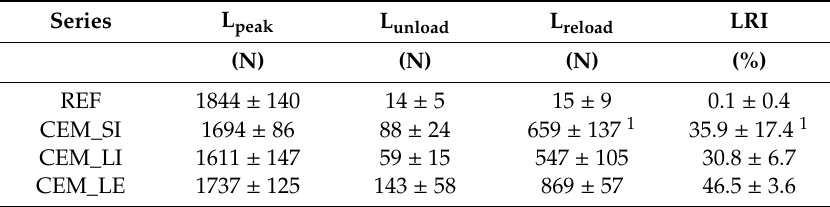
Table 4. Overview of L peak and L unload (average values and standard deviations over 12 specimens per series), L unload and LRI (average values and standard deviations over six specimens per series apart CEM_SI 1